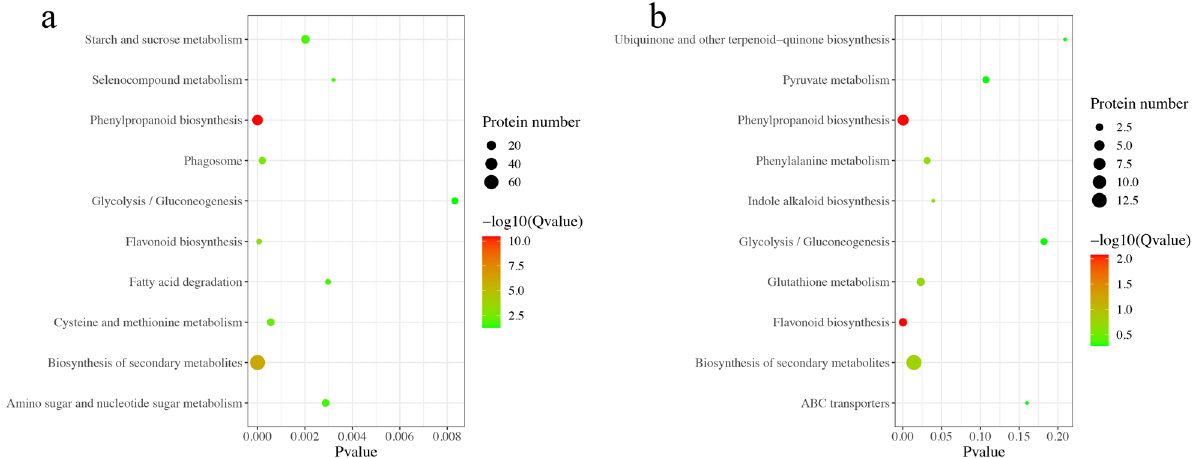
Figure 3. KEGG pathway enrichment of DAPs under ABA ( a ) and ABAI ( b )